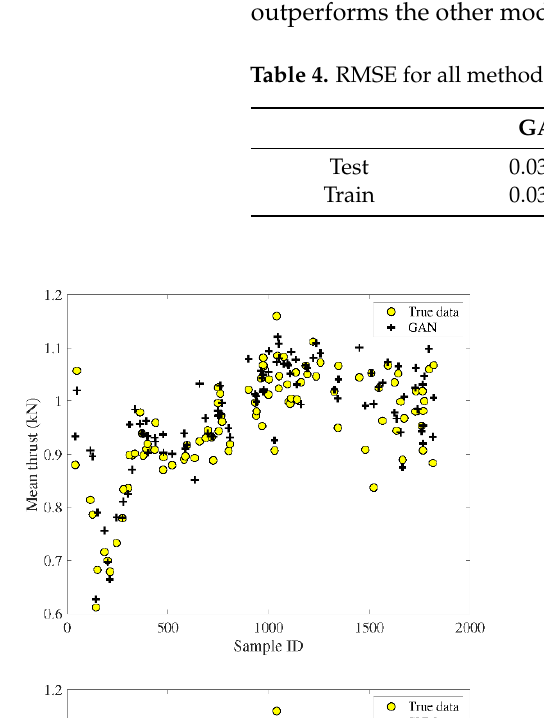
Figure 9. Comparison of the thrust variance prediction of the PMLM models built by proposed GAN and baseline methods.